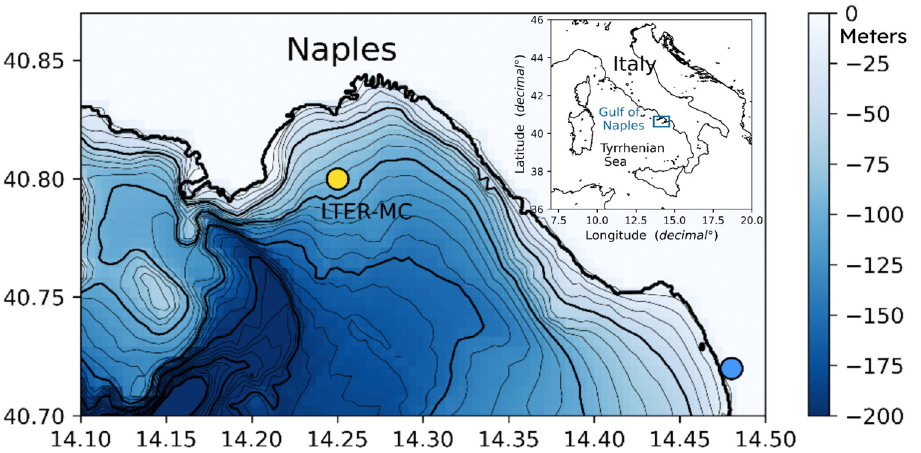
Figure 1. Bathymetry of the Gulf of Naples (GEBCO grid [8]) along the Tyrrhenian Sea in the western Mediterranean basin. The 75 m deep LTER-MC coastal sampling site (14.25 east, 40.80 north) is located by the yellow dot. Thin lines indicate isobaths every 10 m deep, and thick lines every 50 m. On the eastern part of the gulf, the Sarno river mouth is shown in blue.